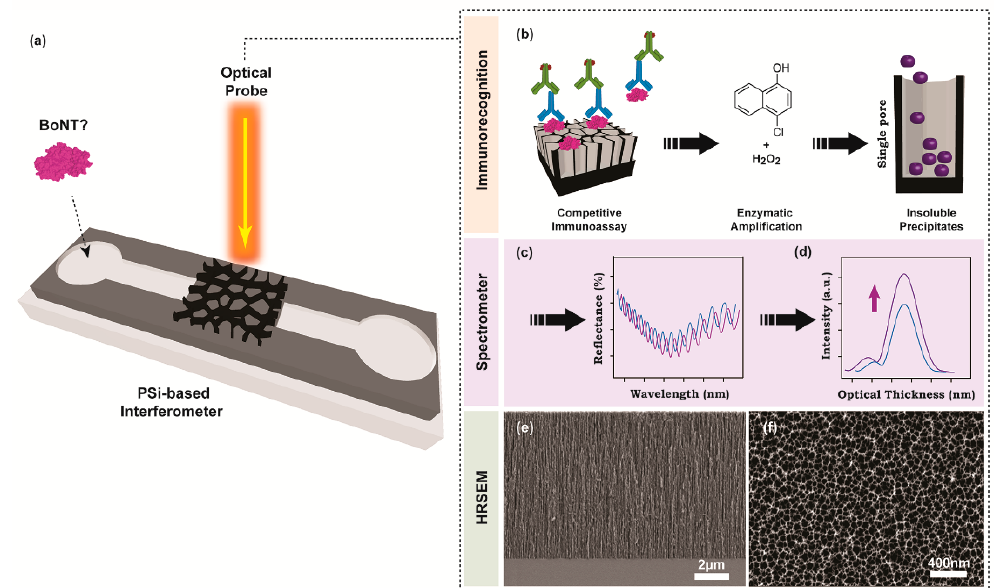
Figure 1. Schematic illustration of nanostructured PSi-based interferometer for the detection of botulinum toxins. ( a ) The PSi nanostructure is illuminated with white light perpendicular to the sample surface, while the reflected light is captured and detected by a miniaturized spectrometer. ( b ) Competitive immunoassay employs highly purified primary antibodies against target analyte (BoNT-C) that are attached to the porous support. Next, secondary antibodies modified with HRP are applied to amplify the optical signal. The amplification reaction includes the oxidation of 4CN substrate in the presence of hydrogen peroxide to produce insoluble products that precipitate and accumulate within the pores. ( c ) The catalytic reaction is monitored in real-time by the RIFTS approach. ( d ) The obtained reflectance spectrum is Fourier transformed into an indicative peak with characteristic effective optical thickness and amplitude (intensity), which correlate with enzymatic reaction product infiltration into the pores. HRSEM micrographs of a typical oxidized PSi thin film. ( e ) Cross-section and ( f ) top views.